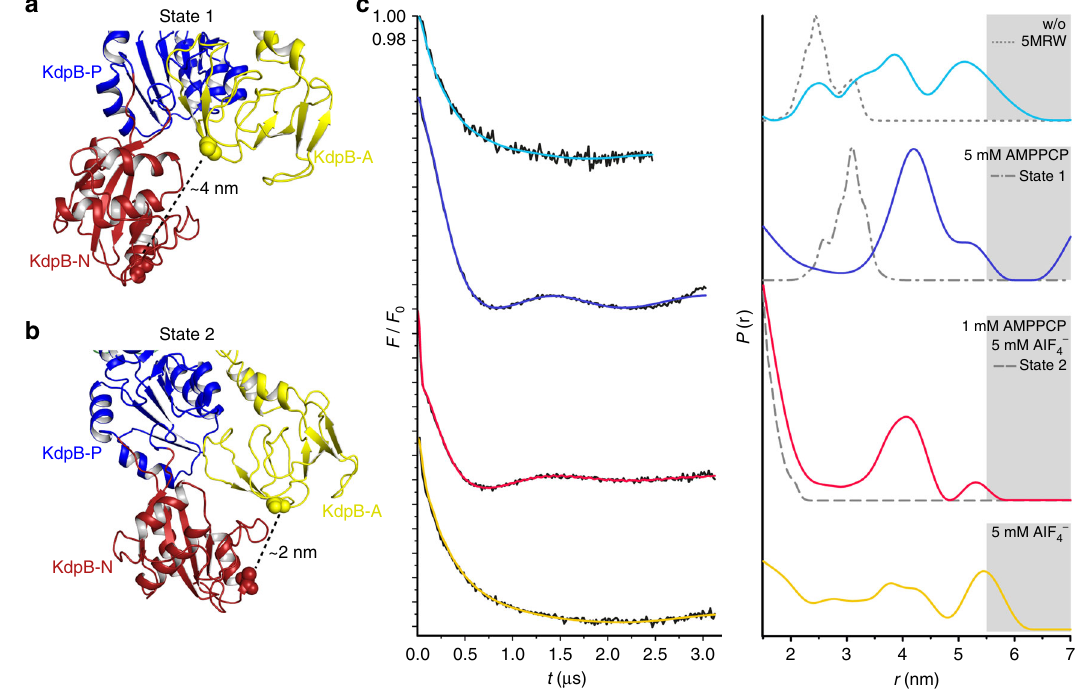
Fig. 2 DEER measurements of KdpFABC with different inhibitors. a , b Cytoplasmic N, P, and A domains shown in state 1 ( a ) and state 2 ( b ). Respective cytoplasmic domains of variant KdpFAB G150CR1/A407CR1 C are labeled, modi fi ed residues G150 (A domain) and A407 (N domain) are shown as spheres, and approximate C α − C α distances are indicated. Views are rotated 180° relative to Fig. 1c, d. c Left panel: dipolar evolution function F(t) with applied fi t (colored lines). Right panel: area-normalized interspin distance distribution P(r) (colored lines) obtained by Tikhonov regularization. Gray areas indicate unreliable distances dependent on the dipolar evolution time. Dashed gray lines represent the predicted distance distributions of state 1, state 2 and the previously published crystal structure [5MRW] 4 , respectively, using the rotamer library analysis